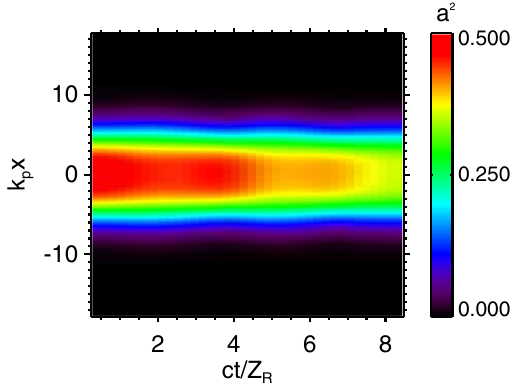
FIG. 3. Integrated transverse intensity profile of a Gaussian and Hermite-Gaussian ( m ¼ 1 ) pulse with orthogonal polariza- tion, as a function of propagation distance, with a 0 ¼ 0 : 7 and a 1 ¼ 0 : 5 .